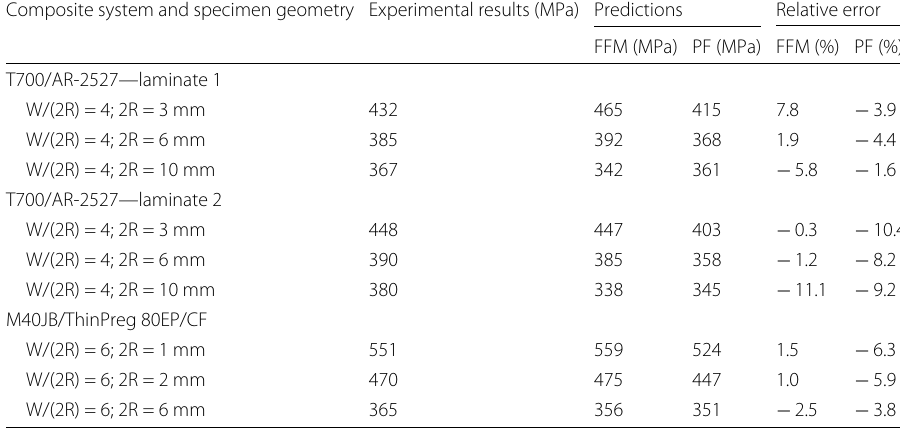
Table 1 Experimental results and numerical predictions Composite system and specimen geometry Experimental results (MPa) Predictions